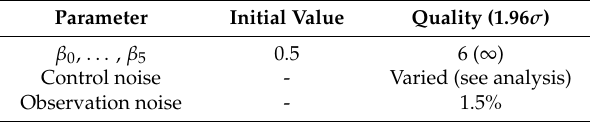
Table 2. Assumed initial condition and measurement